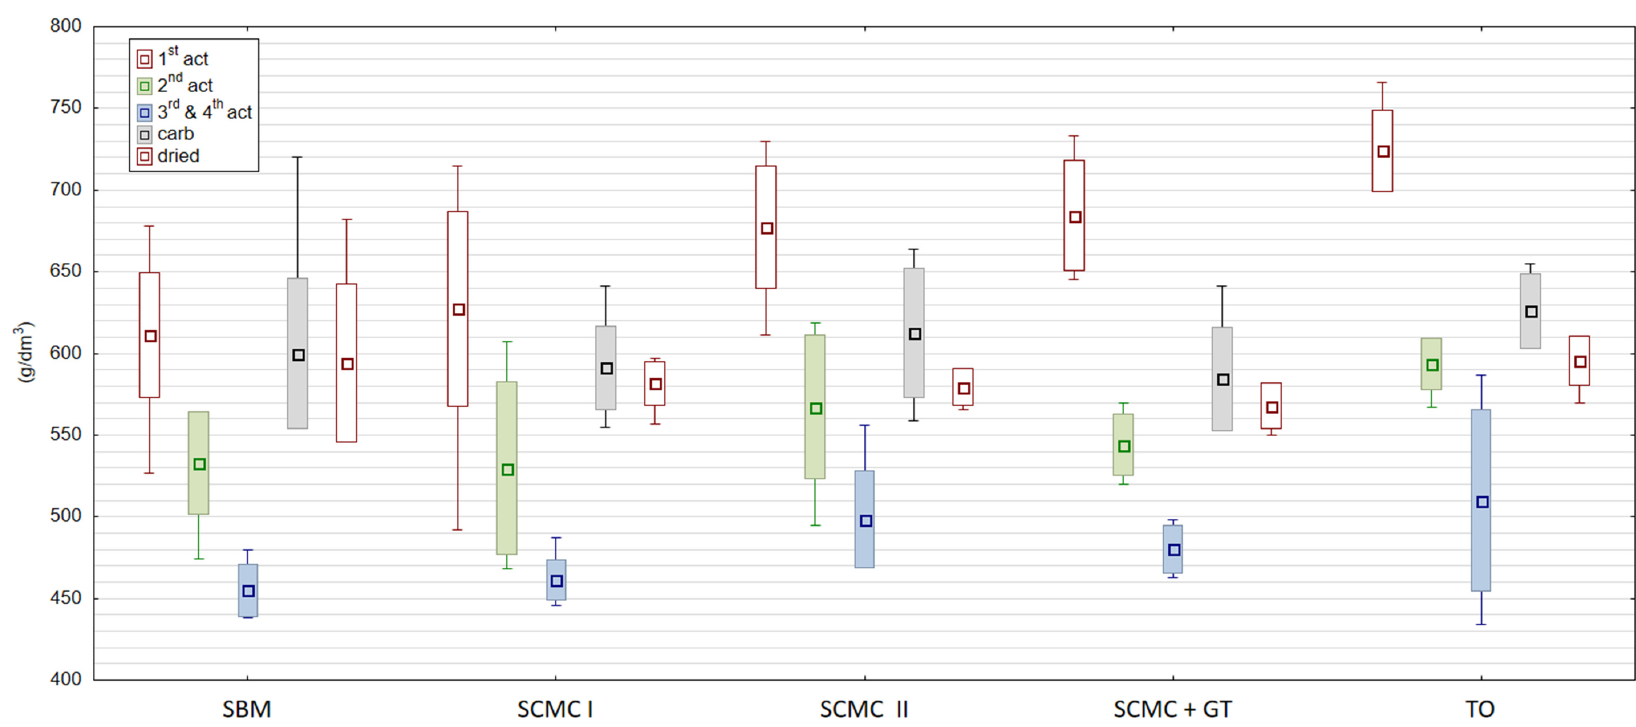
Figure 1. Bulk mass of activated carbons after individual production series (g/dm³). Source: own elaboration. 1 st act—first activation series, 2 nd act—second activation series, 3 rd and 4 th act—third and fourth activation series, carb—carbonization, dried—granules drying.